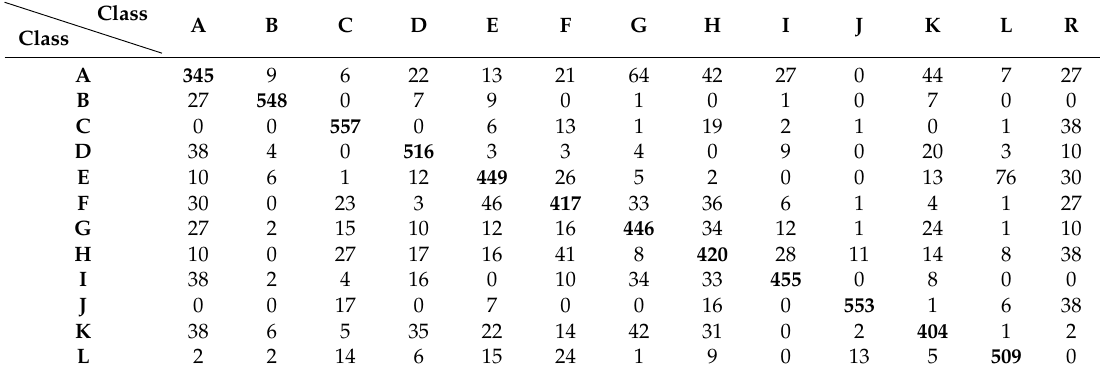
Table 1. Classification results for HOG feature set with MLP Classifier.